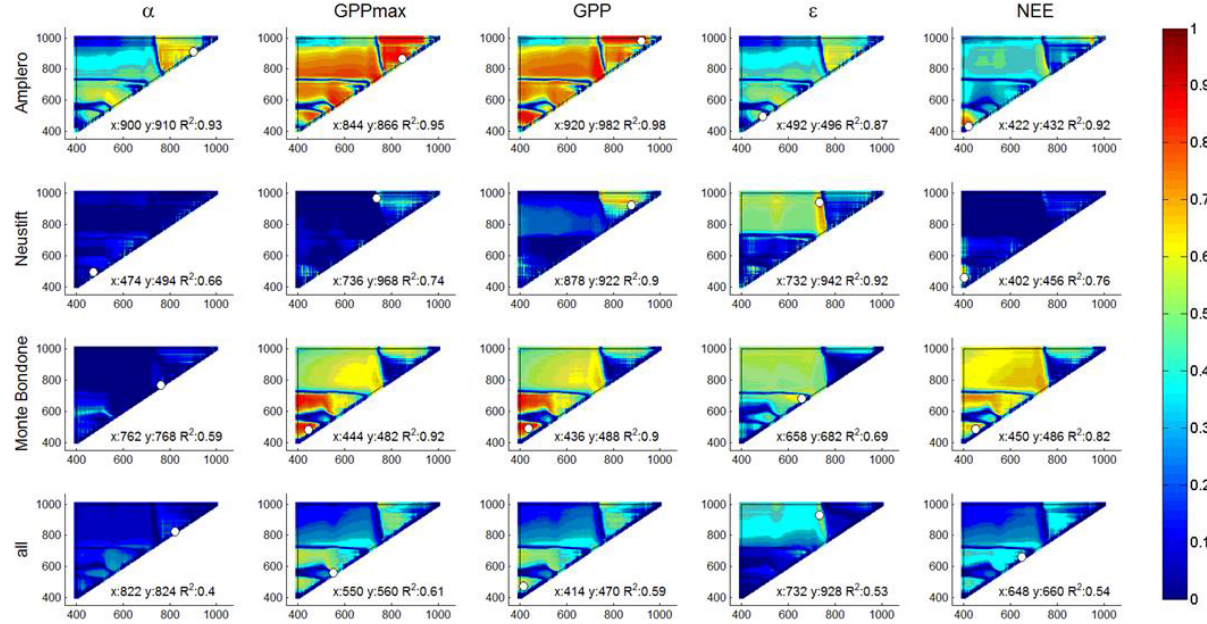
Figure 5. Correlograms of R 2 values for α , GPP max , midday averaged GPP, ε and NEE, on the one hand, and SD-type indices for Amplero, Neustift, Monte Bondone (both study years pooled) and all sites pooled on the other. The white dots indicate the position of paired band combinations corresponding to the maximum R 2